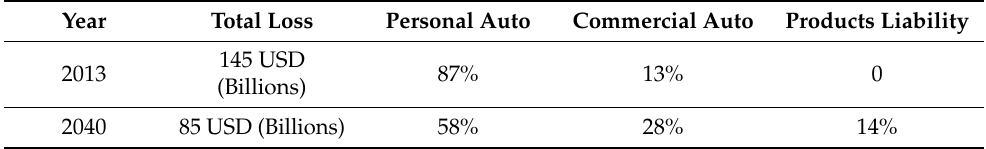
Table 5. Loss splits between personal auto, commercial auto, and product liability adapted from